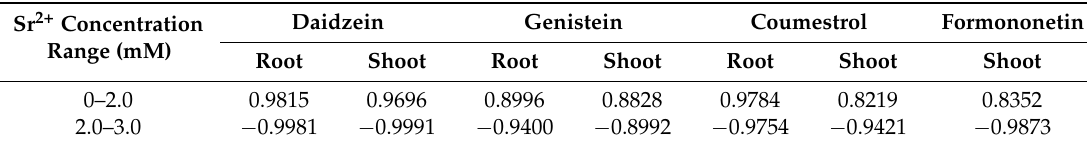
Table 3. Correlation coefficient (r) between the concentration of strontium in medium and the content of phytoestrogens in Glycine max ( n = 5).